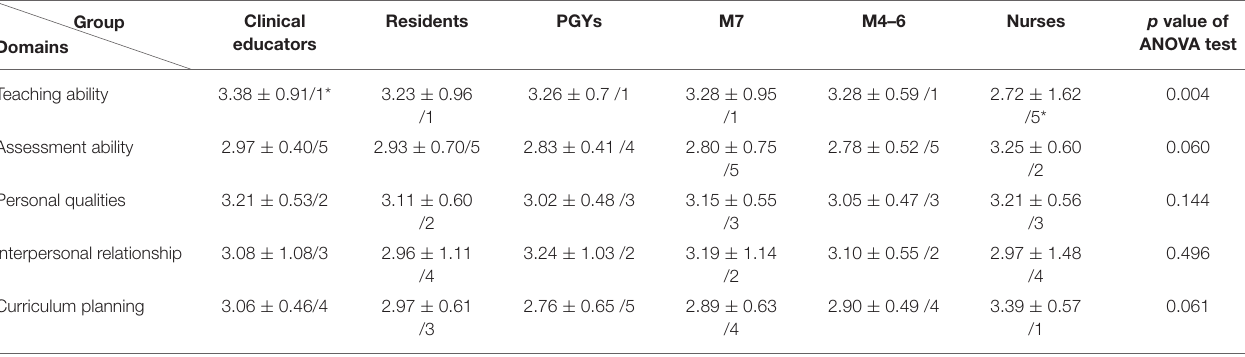
TABLE 2 | Mean ± SD/Rank of the domains for evaluating clinical educators across different respondent